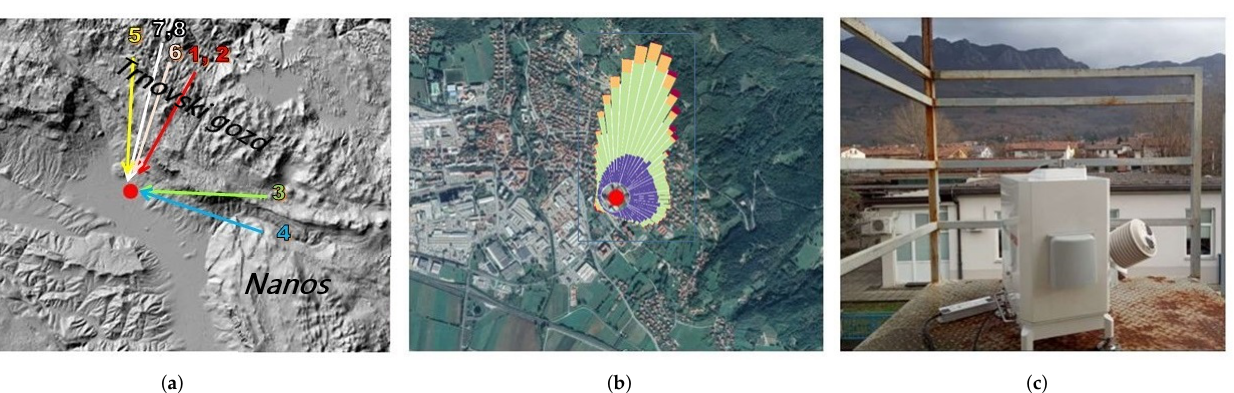
Figure 1. ( a ) The measurement site at Ajdovšˇcina (106m a.s.l.), marked by a red circle, is located in the Vipava valley, and surrounded by Nanos plateau (1262 m) to the north and Goli vrh (710 m) to the south. Prevailing wind directions of eight selected wind episodes are marked with different colors and numbers. ( b ) Cumulative distribution of wind direction during all selected Bora episodes at the measurement site is represented by the wind rose. ( c ) Doppler wind lidar was placed at the 10m height AGL at the measurement site and collected measurements of radial velocity at different heights from 50–230 m AGL during November and December